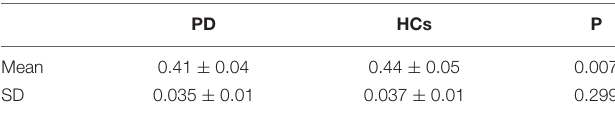
TABLE 2 | Comparison of volume-wise concordance indices between PD patients and